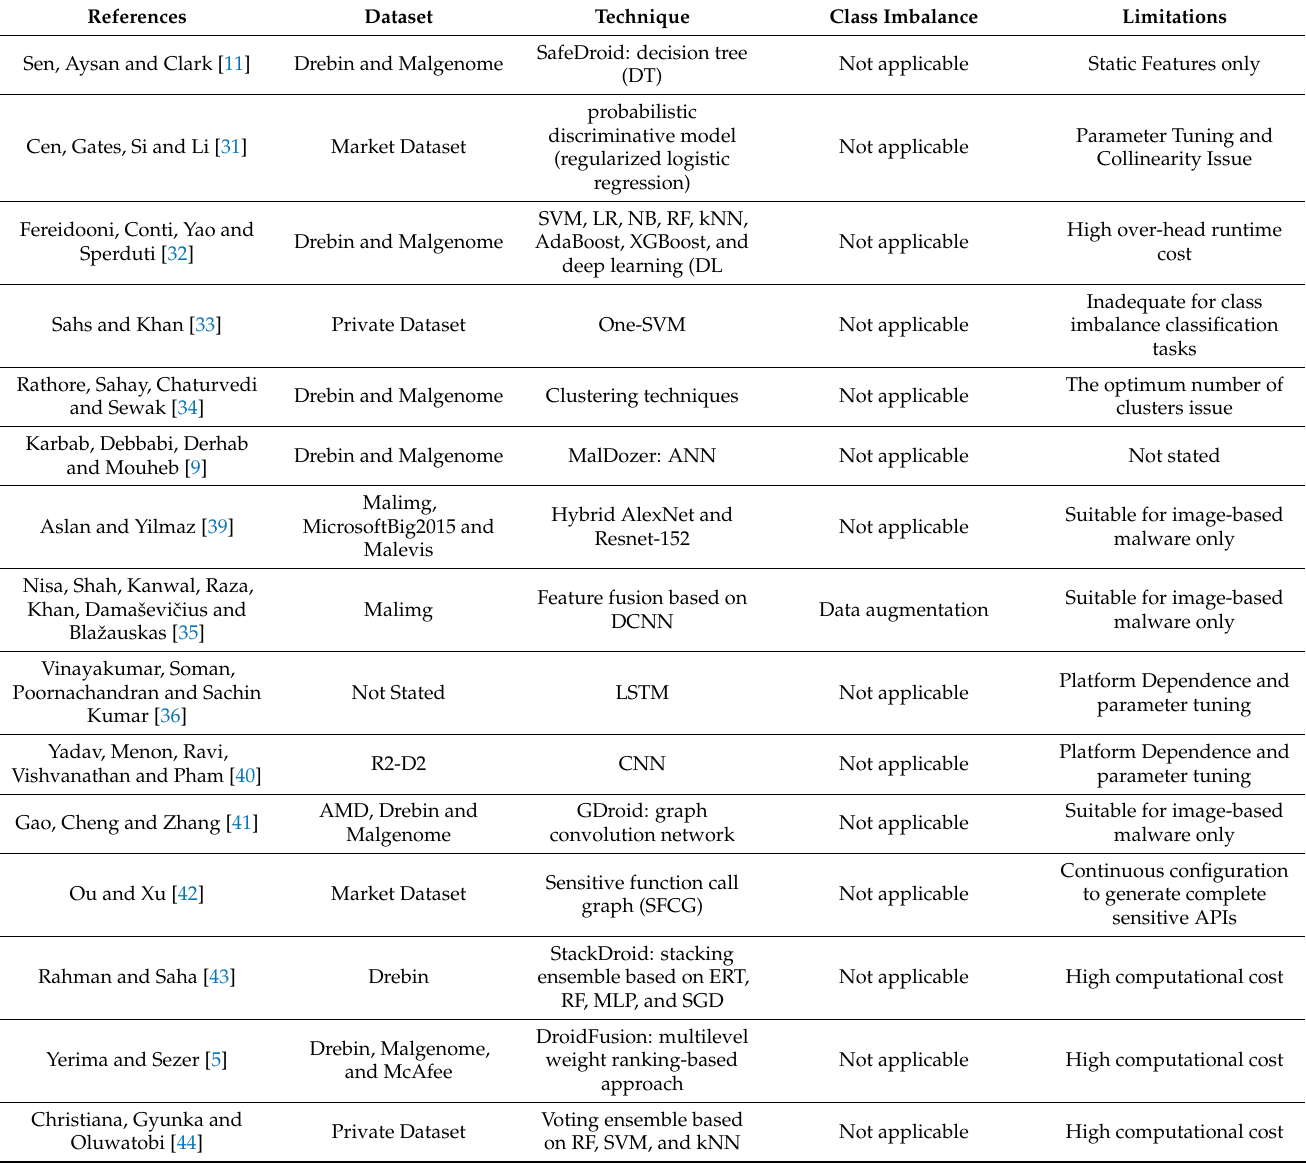
Table 1. Summary of key-related